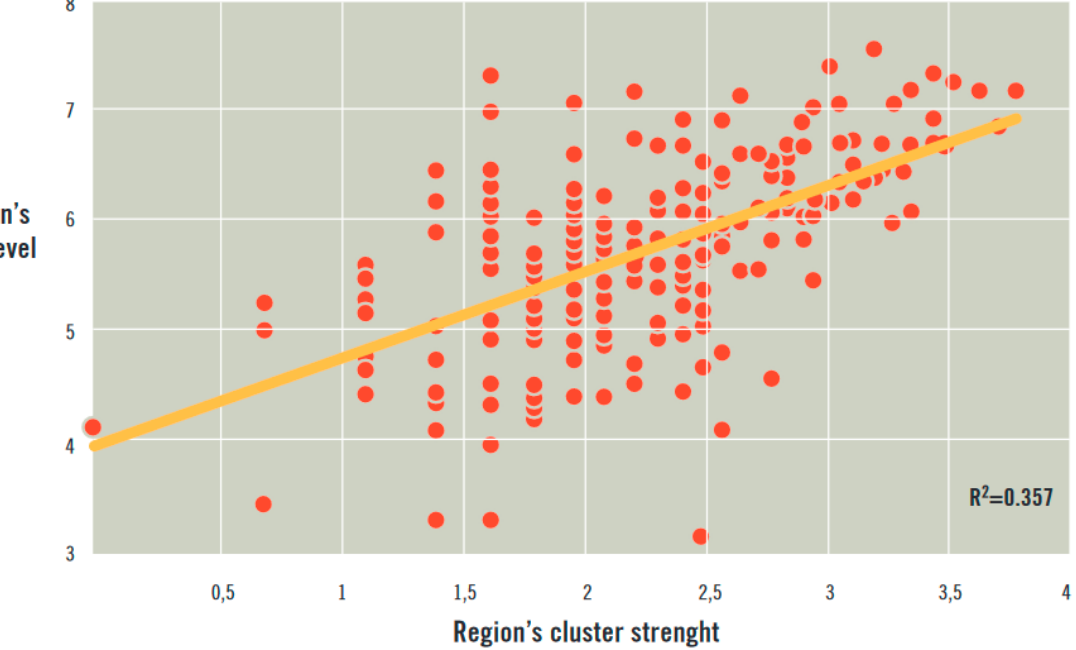
Figure 2. Cluster Strength and Patenting Level in European Regions. Source: “The Concept of Clusters and Cluster Policies and their role for Competitiveness and Innovation: Main statistical results and lessons learned”.